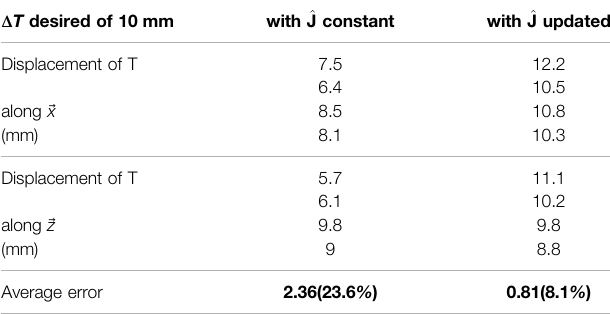
TABLE 2 | Displacement standard for each transverse side given by Apollo with ^ J constant and